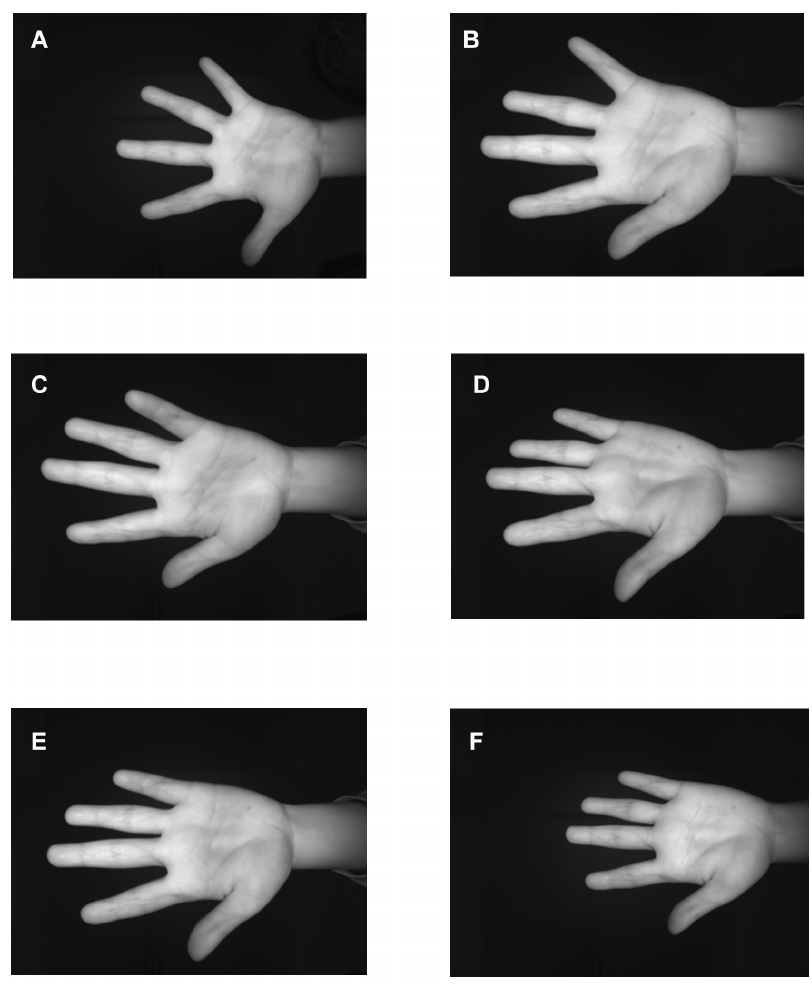
Figure 10. Samples in our database. (a) Far from the camera lens; (b) Close to the camera lens; (c) Tilts to the left; (d) Tilts to the right; (e) Tilts forward; (f) Tilts backward.